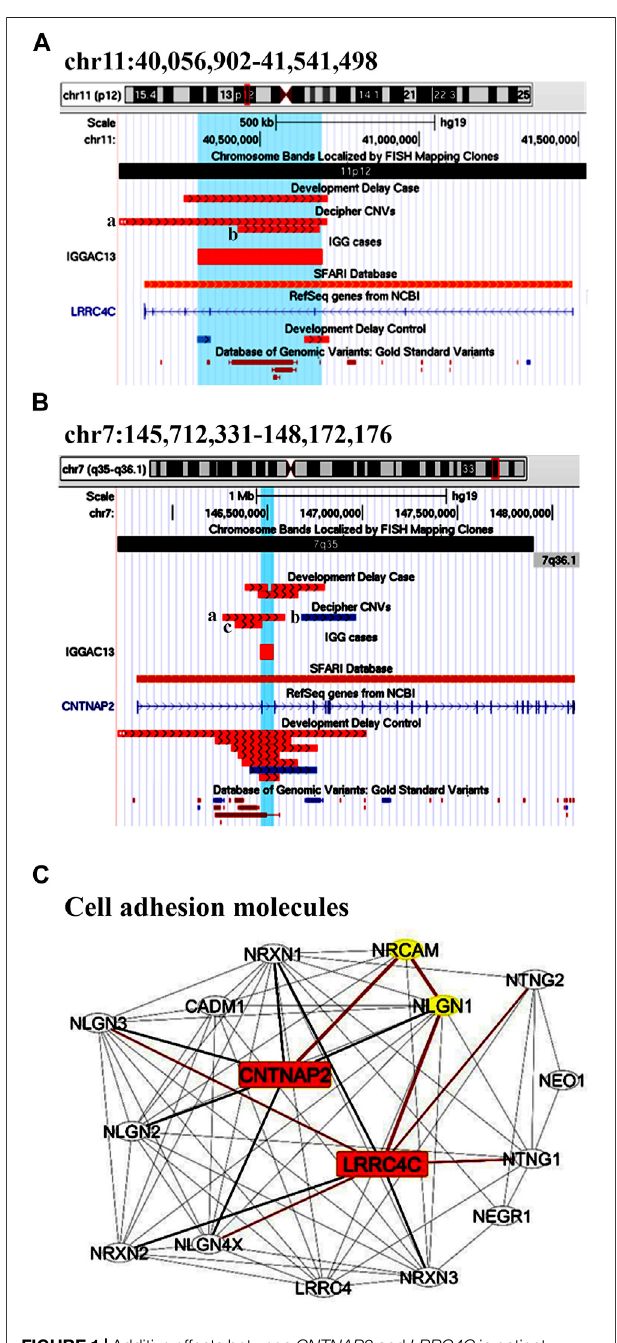
FIGURE 1 | Additive effects between CNTNAP2 and LRRC4C in patient IGGAC13. (A ) Screenshots of chromosome 11 region overlapping the deletion of patient IGGAC13 (red bar IGGAC13, chr11:40,303,114- 40,694,847).DecipherCNVs(a:deletioninpatient282991;b:deletionin patient 276911). (B) Screenshots of chromosome 7 region overlapping the deletion of patient IGGAC13 (red bar IGGAC13, chr7:146,464,283- 146,532,437). Decipher CNVs (a: deletion in patient 319381; b: intragenic duplication in patient 255117; c: deletion in patient 250646). Only Decipher patients with additional CNVs that overlap neurodevelopmental genes were selected and reported in the fi gure. (C) The network depicts the protein- protein interactions (grey lines), experimentally determined interaction (red lines) and co-expression (bold black lines) of the KEGG pathway “ Cell